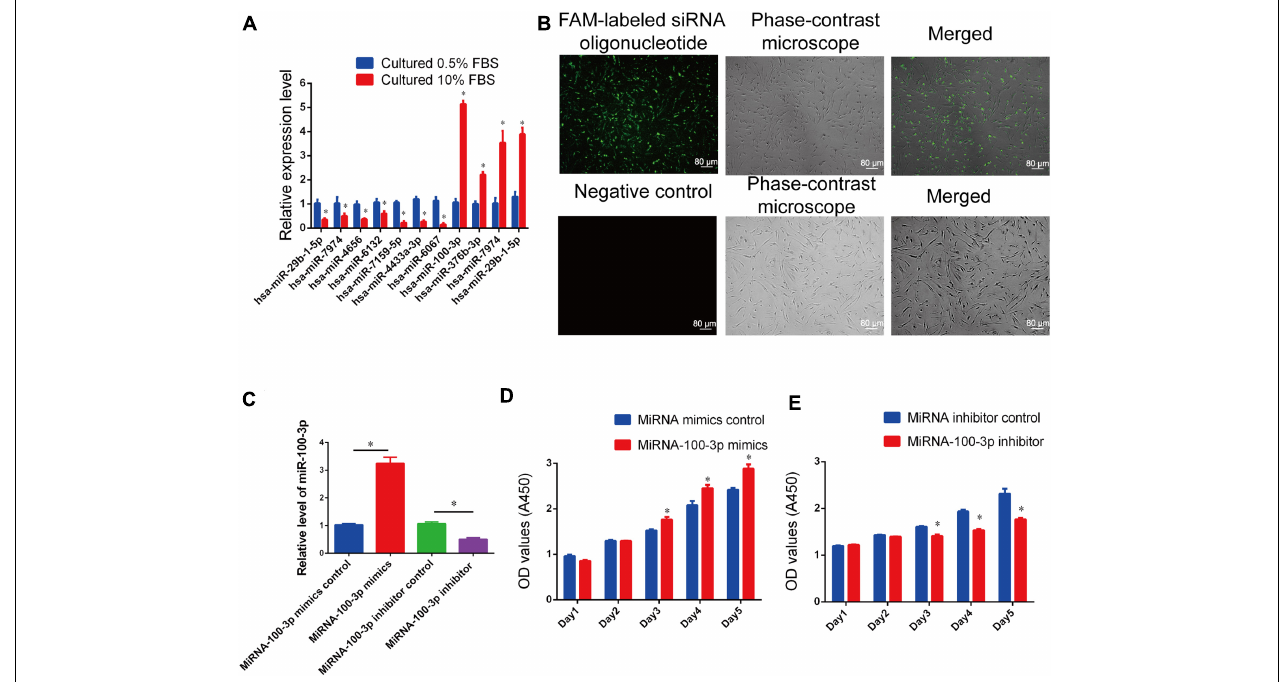
FIGURE 2 | MiR-100-3p controls human Sertoli cell proliferation. (A) Real-time qPCR showed the relative expression levels of Homo sapiens-microRNA (hsa-miR)-29b-1-5p, hsa-miR-7974, hsa-miR-4656, hsa-miR-6132, hsa-miR-7159-5p, hsa-miR-4433a-3p, hsa-miR-6067, hsa-miR-100-3p, hsa-miR-376b-3p, hsa-miR-7974, and hsa-miR-29b-1-5p in human Sertoli cells by 10% fetal bovine serum (FBS) compared with 0.5% FBS. (B) The transfection efficiency of miR-100-3p mimics and inhibitor was evaluated by fluorescence microscope and phase-contrast microscope. Scale bar = 80 µ m. (C) The relative expression levels of miR-100-3p in human Sertoli cells treated with miR-100-3p mimics or inhibitor. (D,E) The cell growth of human Sertoli cells treated with miR-100-3p mimics (D) and miR-100-3p inhibitor (E) for 5 days. * denoted the statistical difference between miR-100-3p mimics and miRNA mimics control or miR-100-3p inhibitor and miRNA inhibitor